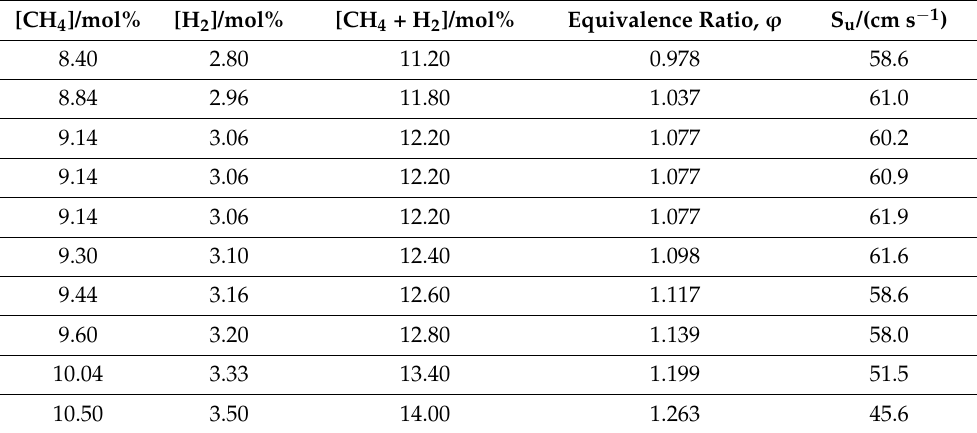
Table 3. Typical values of Su for H 2 -blended CH 4 mixed with air at r H =